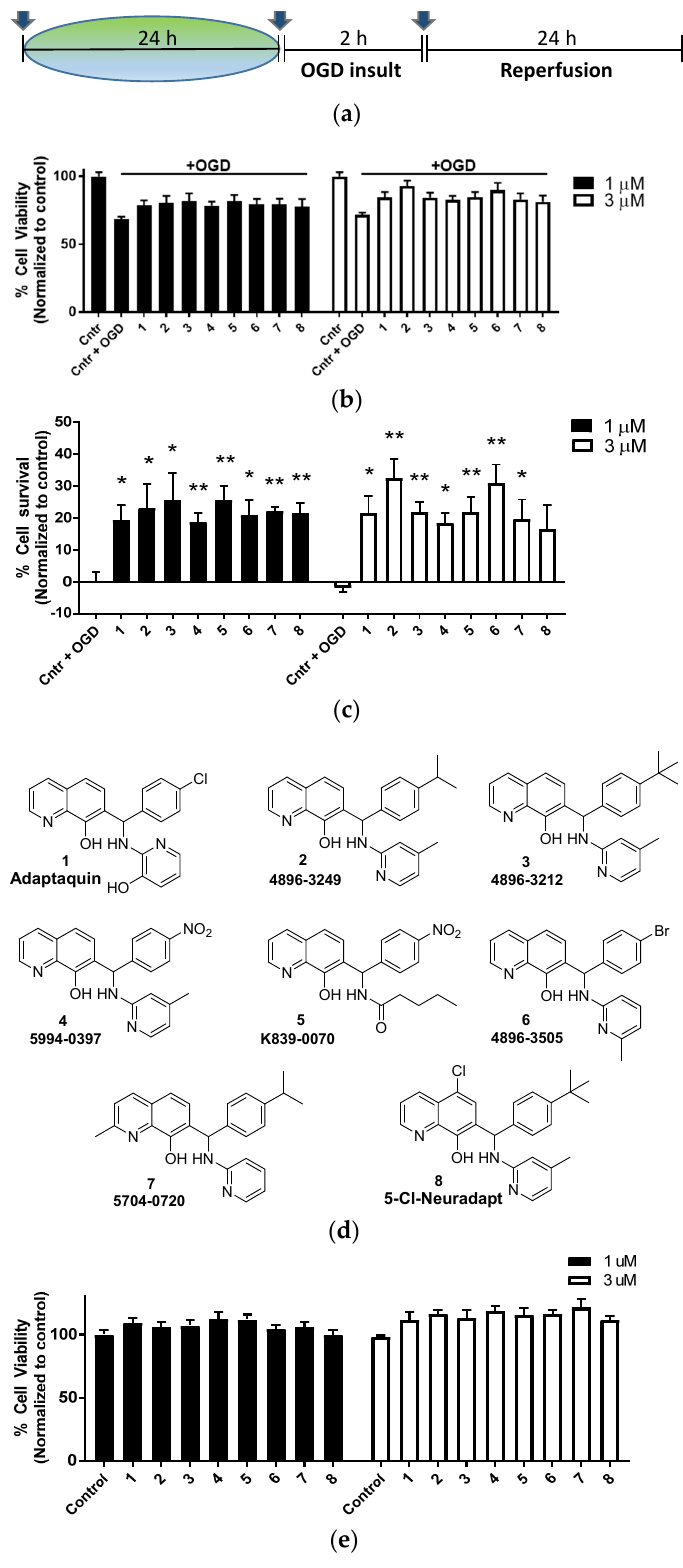
Figure 6. HIF PHD inhibitors protect SH-SY5Y cells subject to OGD: timeline ( a ); cell viability measured after 24 h of incubation using the MTT assay ( b ); 24 h pretreatment ( c ). Data show mean and SEM normalized to control ( n = 6): * p < 0.05, ** p < 0.01 versus insult by a one-way ANOVA test; HIF PHD inhibitors structures ( d ); The absence of toxicity of the studied compounds at 48 h incubation ( e ).